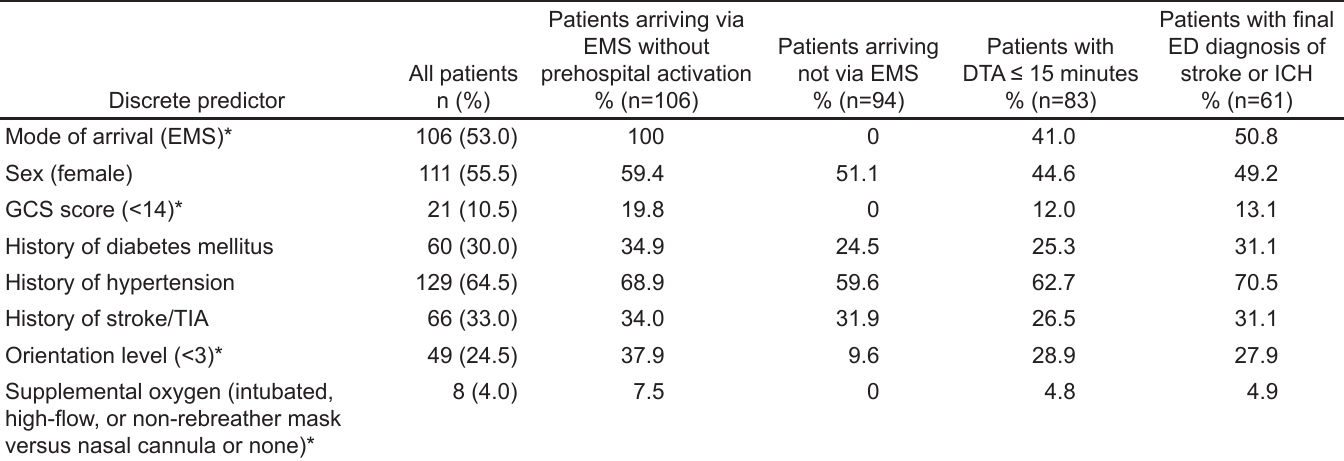
Table 1A. Discrete predictor variables and study subject characteristics.